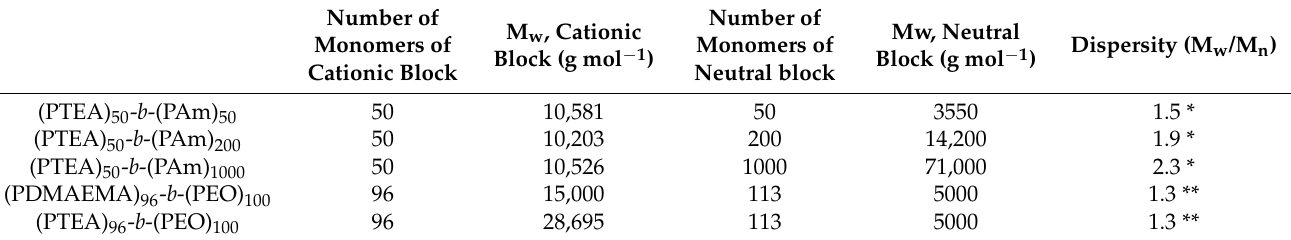
Table 1. Composition of the copolymers